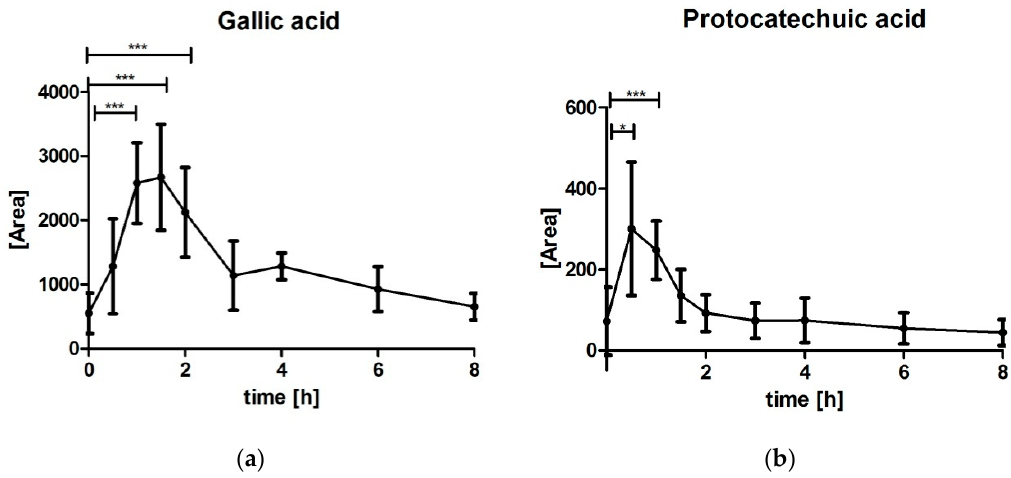
Figure 4. Gallic acid and protocatechuic acid concentration time profiles after intake of maqui berry extract presented as summary curves of mean values of area units at single time points (mean ± 95% CI, * p < 0.05; *** p ≤ 0.001): ( a ) Gallic acid [area units] ( N = 8 due to exclusion of outliers) ( b ) Protocatechuic acid [area units] ( N = 12).